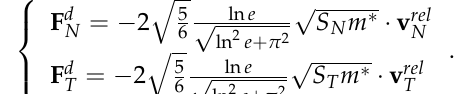
and tangential damping force F d N